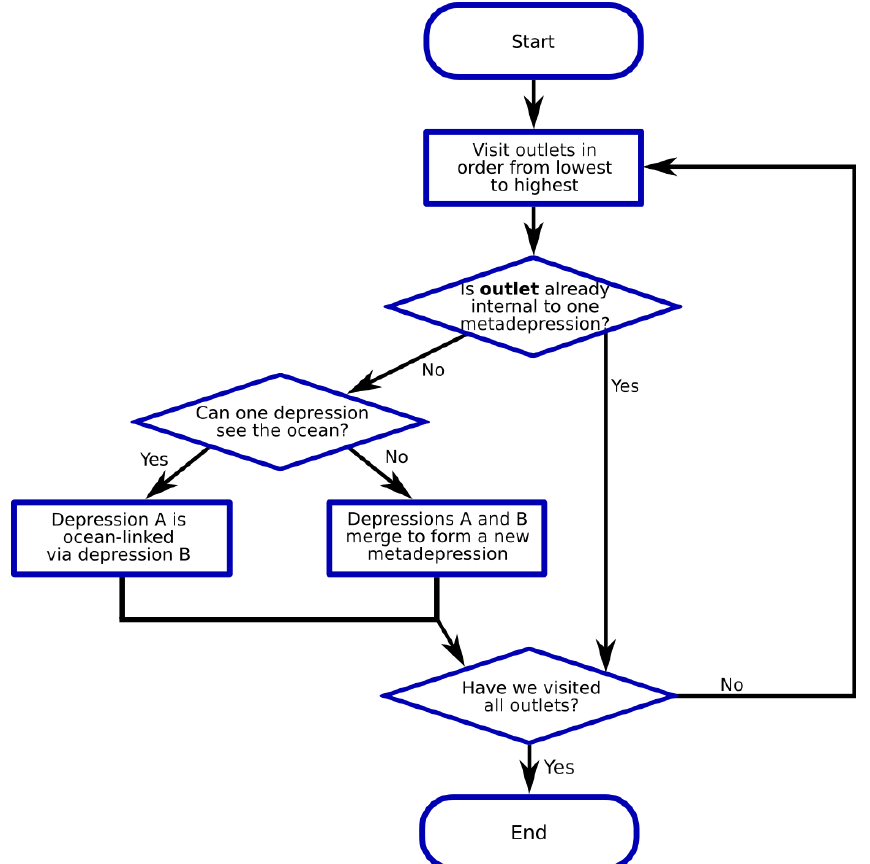
Figure 6. Construction of the forest of binary trees. This forest represents the links between individual depressions (Fig. 1). See Fig. 4 to see how this process fits into the overall depression hierarchy